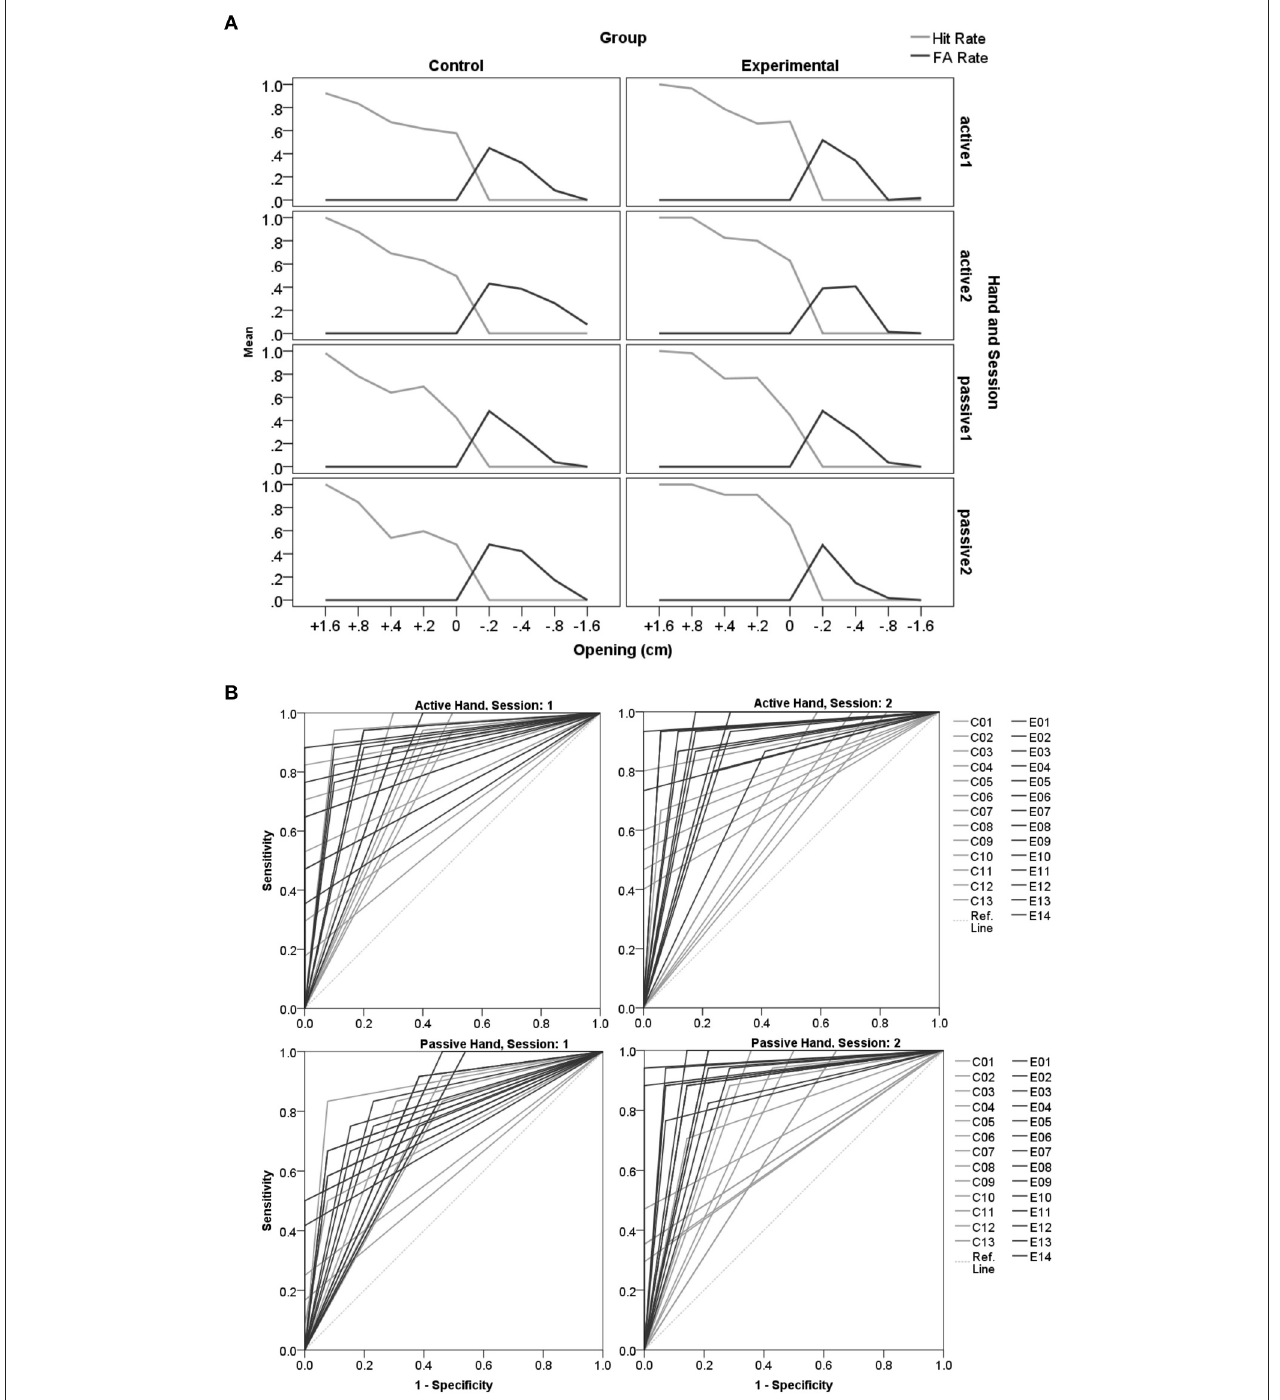
FIGURE 5 | Detection theory approach for the aperture task. (A) Displays an overview of changes in Hit- and False Alarm Rates for the different openings across sessions (1, 2) for the active and the passive hand respectively. In (B) the ROC curves for individual participants are displayed (Control-group C: gray lines; Experimental-group E: black lines) for each session. 1-Specificity reflects the False Alarm Rate, and the Sensitivity indicates the Hit Rate. The reference line is at chance level (Ref. Line: light gray dots). The area under the curve is a measure of accuracy, which is perfect when FA = 0 and Hit = 1 (in the upper left corner). Accuracy significantly improved after feedback in session 2 for the subjects that were assigned to the Experimental compared to the Control-group.